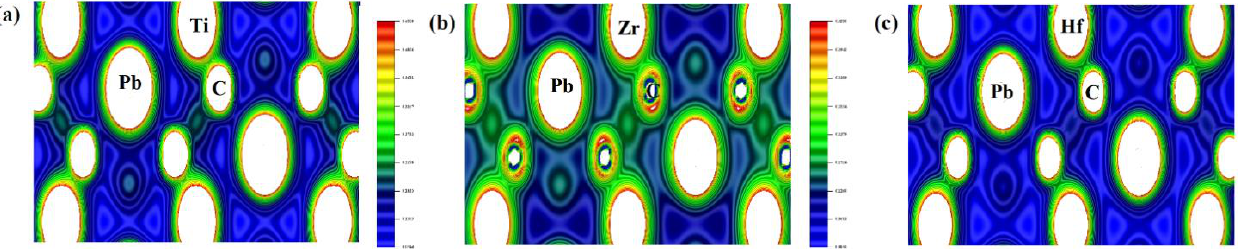
Figure 10. The total densities of states (TDOS) for M 2 PbC (M = Ti, Zr, Hf). The vertical dotted line represents the Fermi level.